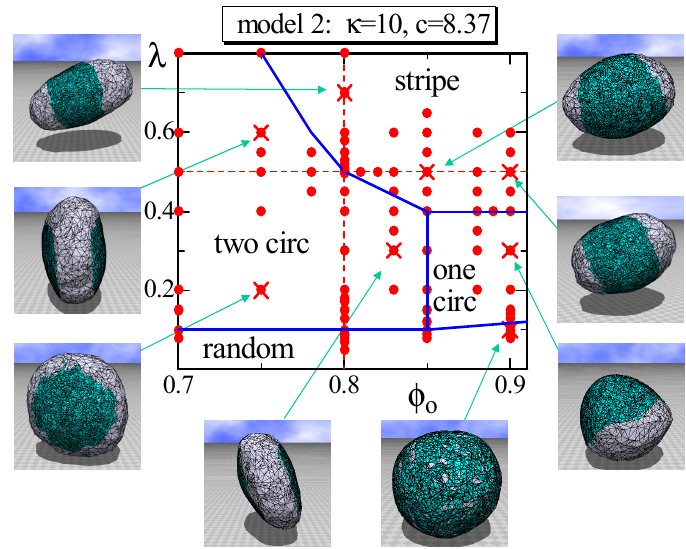
Figure 6. A phase diagram of Model 2 on the λ − φ o plane at κ = 10 and c = 8.37 and the snapshots of surfaces obtained at the points indicated by the symbol ( × ). The solid lines on the phase diagram denote the phase boundaries, and the dashed lines denote the positions for the simulations for Figure 7a–c. The solid circles ( • ) denote the data points of the simulations for the phase boundaries.